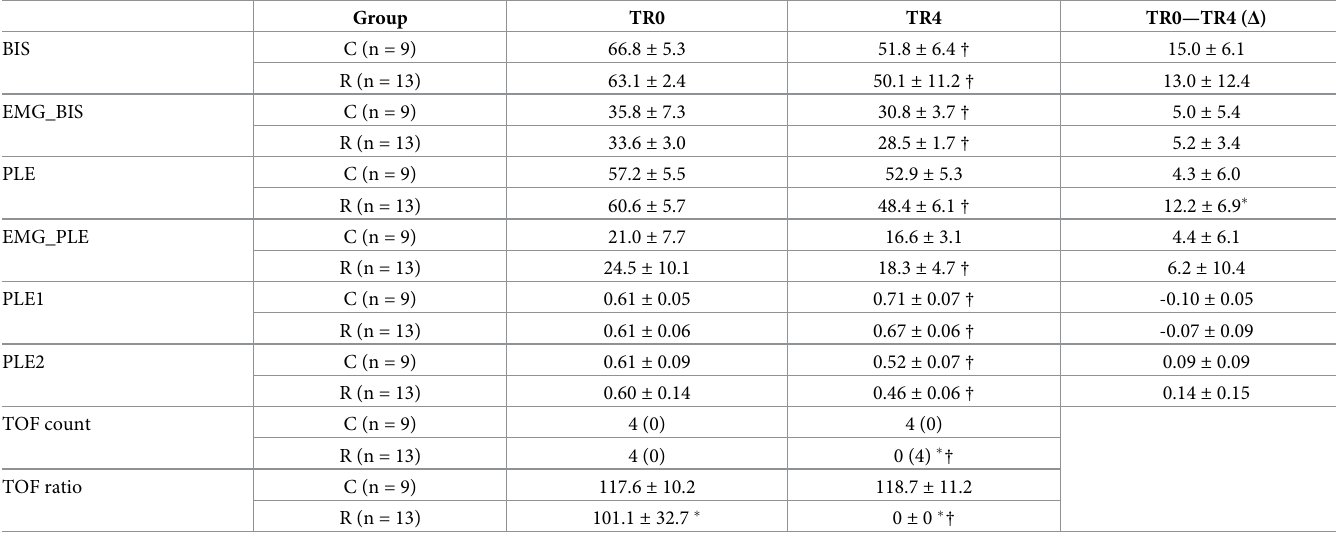
Table 5. Changes in BIS and PLE of patients with